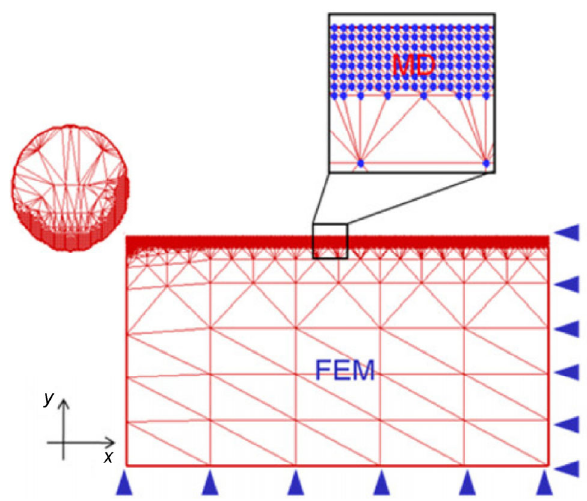
Fig. 4 Multiscale simulation